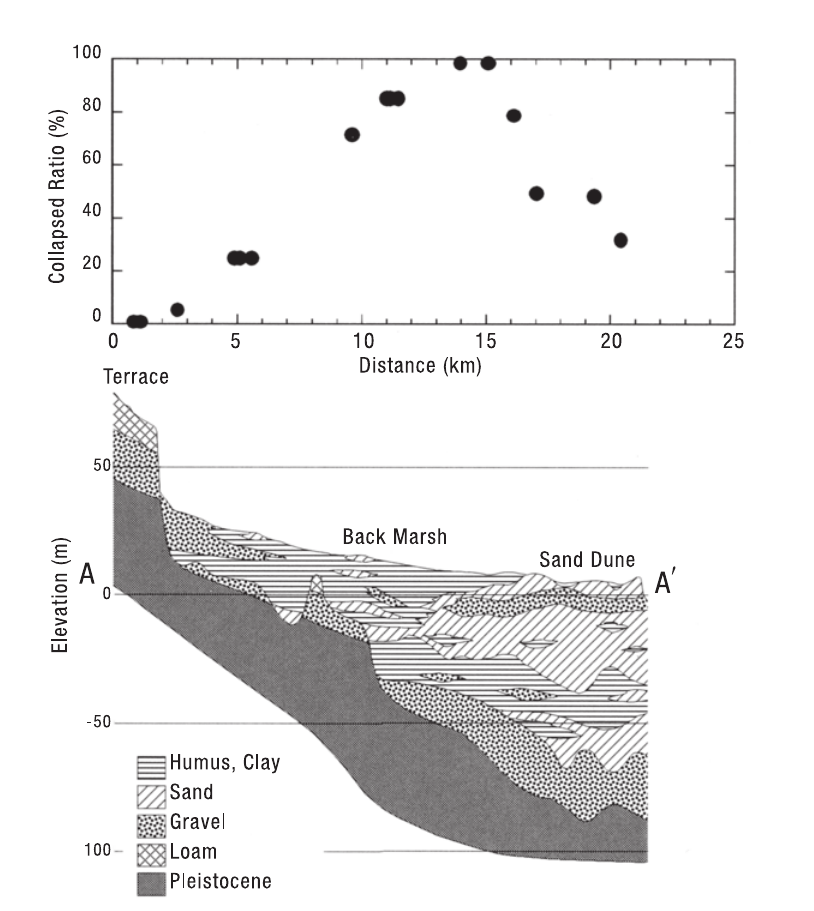
Fig. 10. Soil profile along the Sagami River (Kanagawa Prefecture, 1985) and collapsed